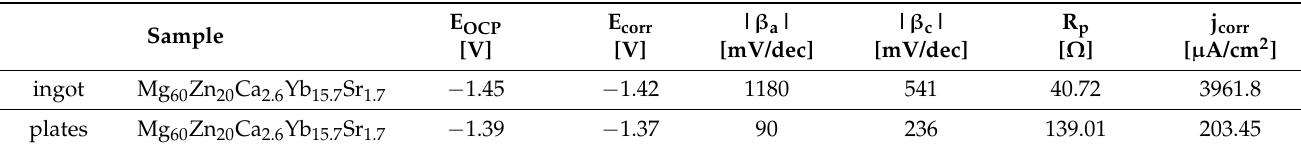
Figure 4. Changes of an open-circuit potential with time ( a ) and polarization curves ( b ) of Mg 60 Zn 20 Ca 2.6 Yb 15.7 Sr 1.7 alloy in a form of ingots and plates. Table 1. Results of electrochemical tests of Mg 60 Zn 20 Ca 2.6 Yb 15.7 Sr 1.7 alloy in a form of ingots and plates (E OCP —open circuit potential, E corr —corrosion potential, β a , β c —anodic and cathodic Tafel slopes, R p —polarization resistance, j corr —corrosion current density).